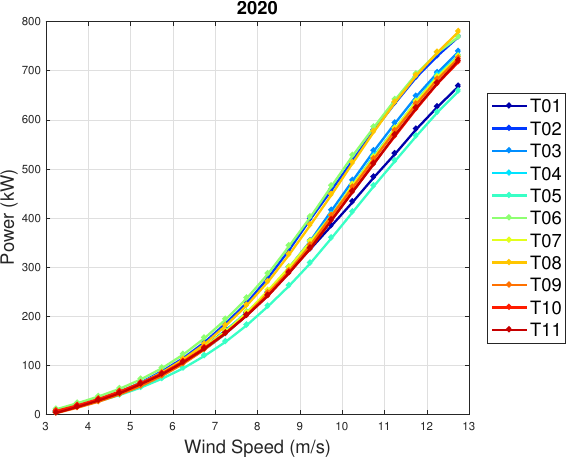
Figure 8. Average power curves for the year 2020: